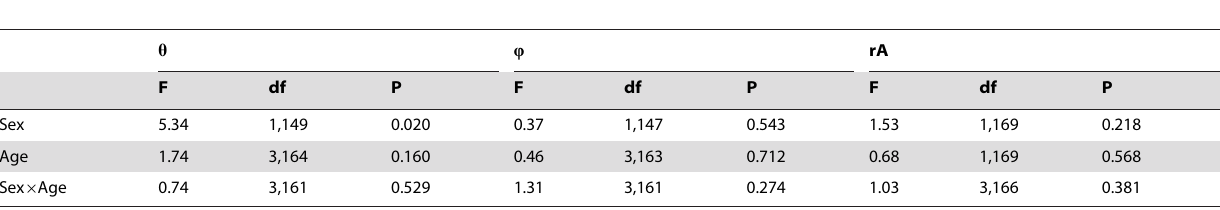
Table 2. Linear mixed models of the difference in tetrahedral color components between survivors and non-survivors in relation to sex and age, with year as a random